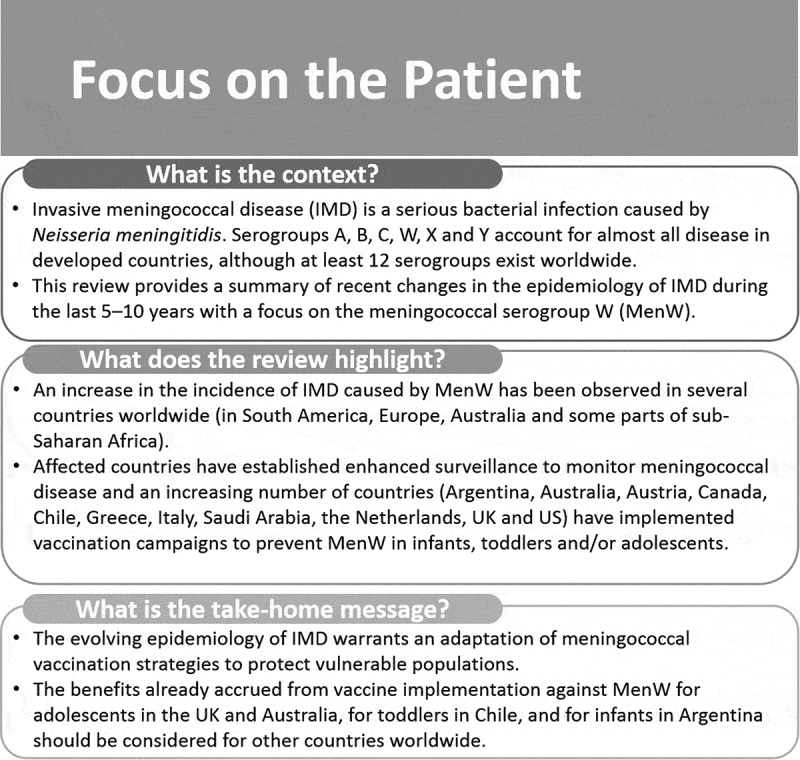
Focus on the patient section.